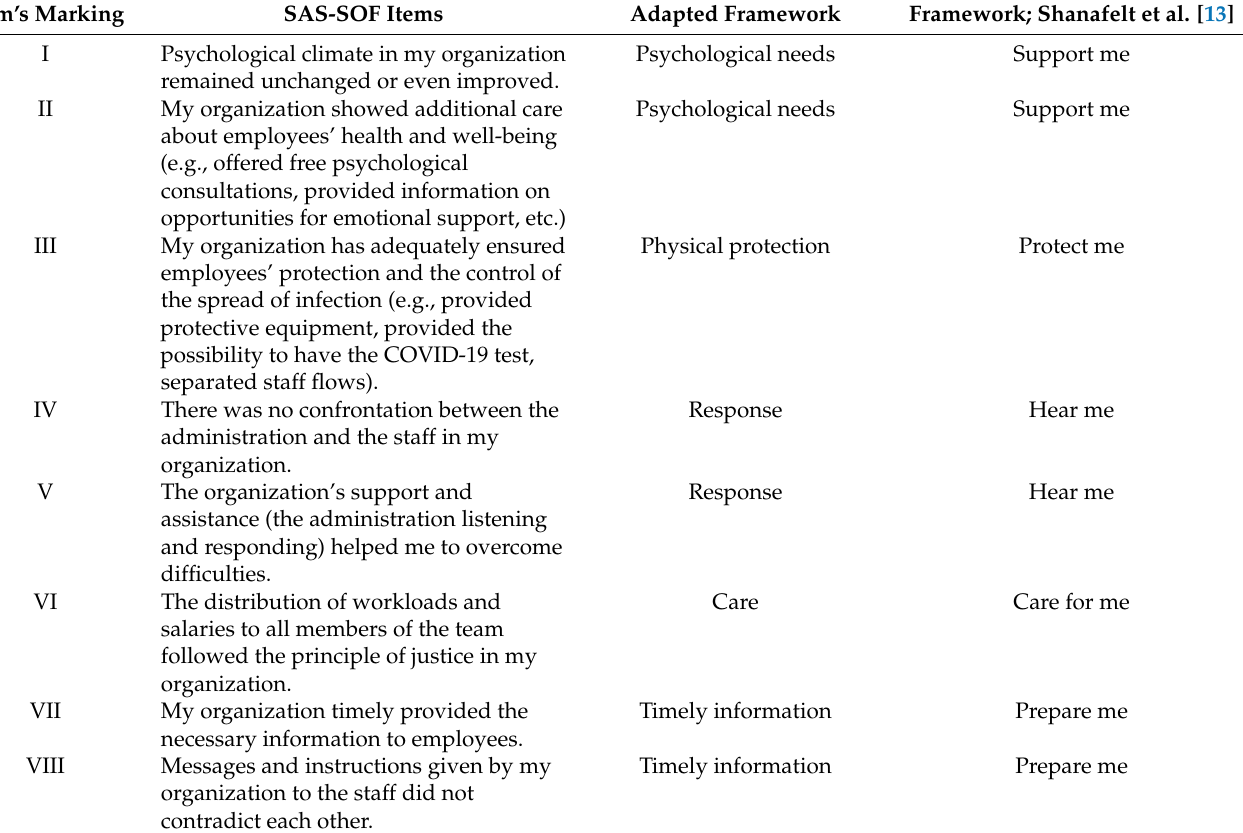
Table 1. Items of safety and stability supporting organizational factors during pandemic (SAS-SOF) group. Item’s Marking SAS-SOF